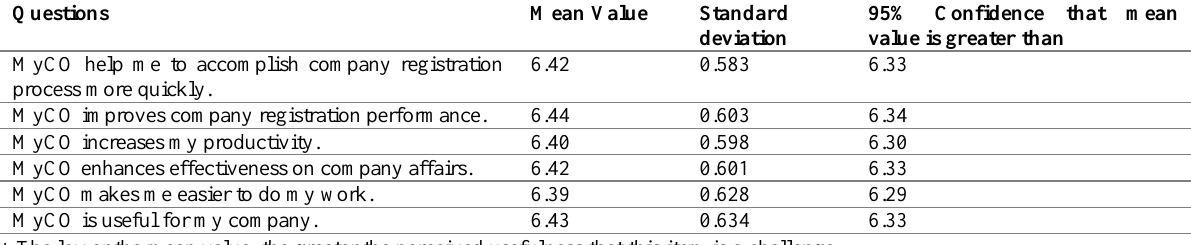
Table 6: Results of questionnaire processing related to perceived usefulness of MyCO system Questions Mean Value